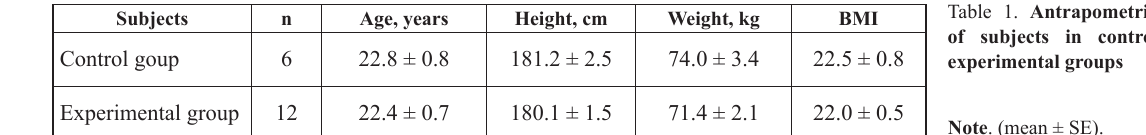
Table 2. The organization of research on calf muscle